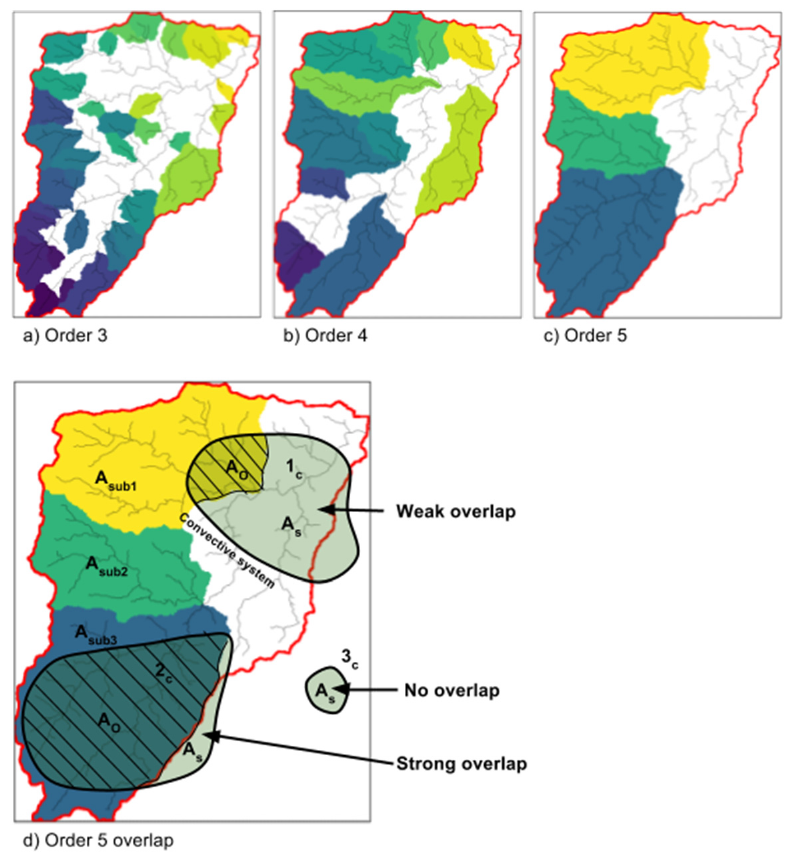
Figure 4. Example of boundary sub-watersheds definitions ( a – c ) and overlap index estimations ( d ). The three top panels describe the boundary sub-watersheds of orders 3, 4, and 5 for the Samana